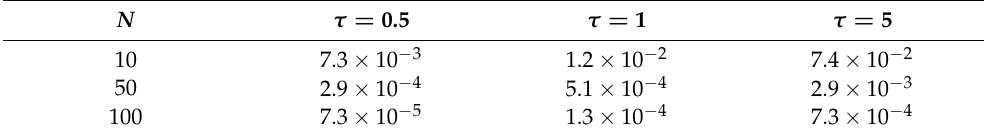
Table 4. The relative errors of the numerical solutions of test problem 4 for a = 1, k = 0.5 and three different delays τ on the interval 0 ≤ t ≤ T = 50 τ